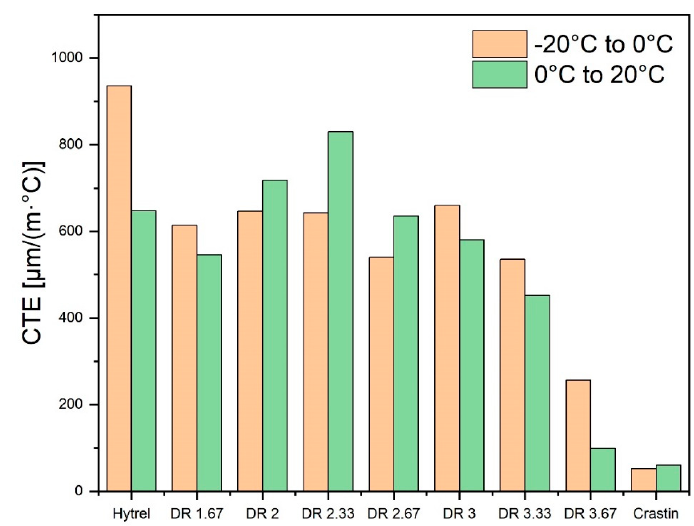
Figure 7. CTE vs. Draw ratios of bicomponent (2nd to 8th columns) and monocomponent fibers (Hytrel and Crastin, 1st and last columns) in the temperature ranges of − 20 °C to 0 °C and 0 °C to 20 °C.